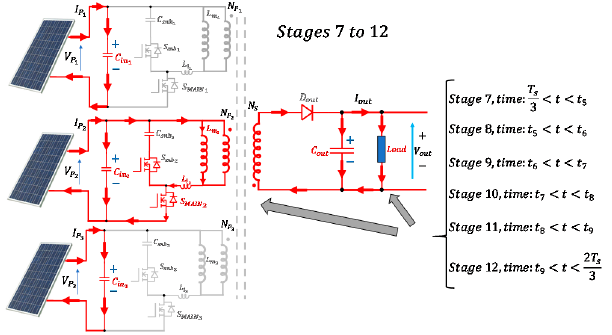
Figure 8. Schematic of stages 7 to 12, time: T s /3 < t < 2 T s /3.